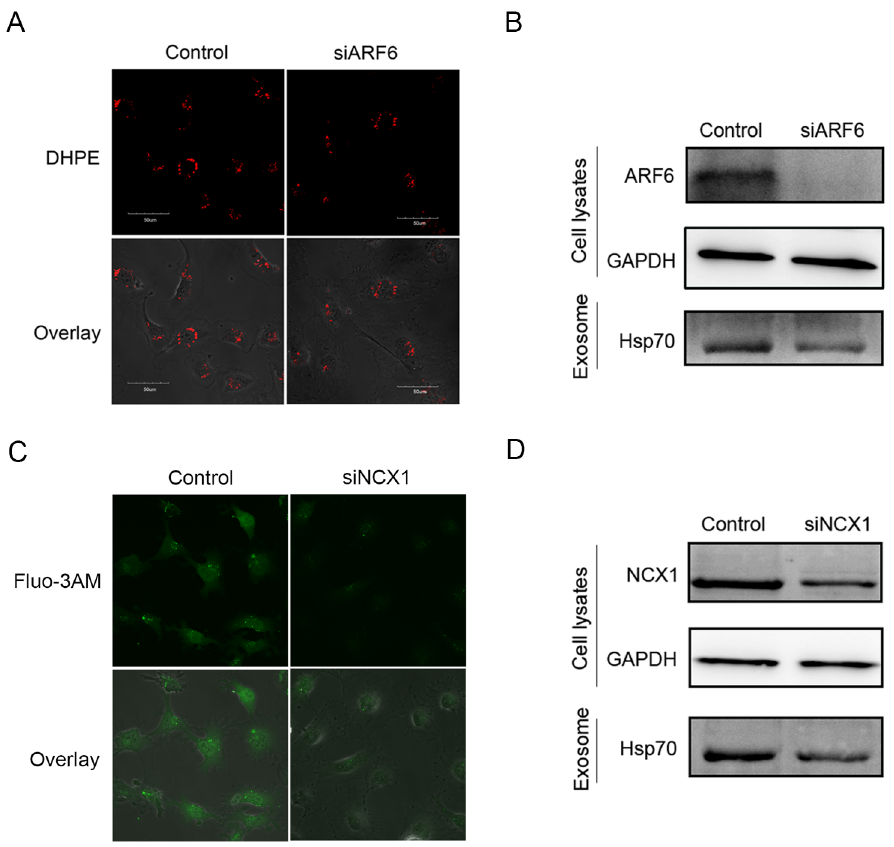
Fig 4. ARF6 and NCX1 mediate exosome production in HUVECs. (A) DHPE staining of intracellular MVBs assayed by confocal microscopy at 600× magnification. (B) Western blot analysis of Hsp70 protein expression in exosomes secreted from ARF6 knockdown HUVECs. (C) Fluo-3AM staining of intracellular calcium assayed by confocal microscopy at 600× magnification. (D) Western blot analysis of Hsp70 protein expression in exosomes secreted from NCX1 knockdown